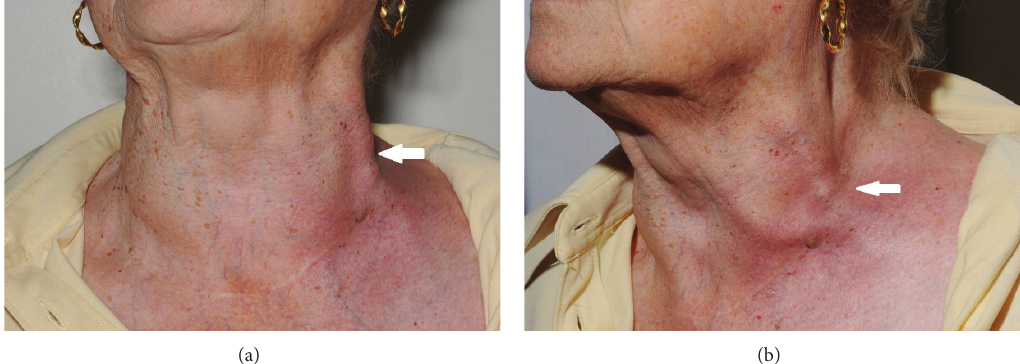
Figure 2: Photographs from fracture clinic demonstrating thrombosis of the external jugular vein with associated superficial